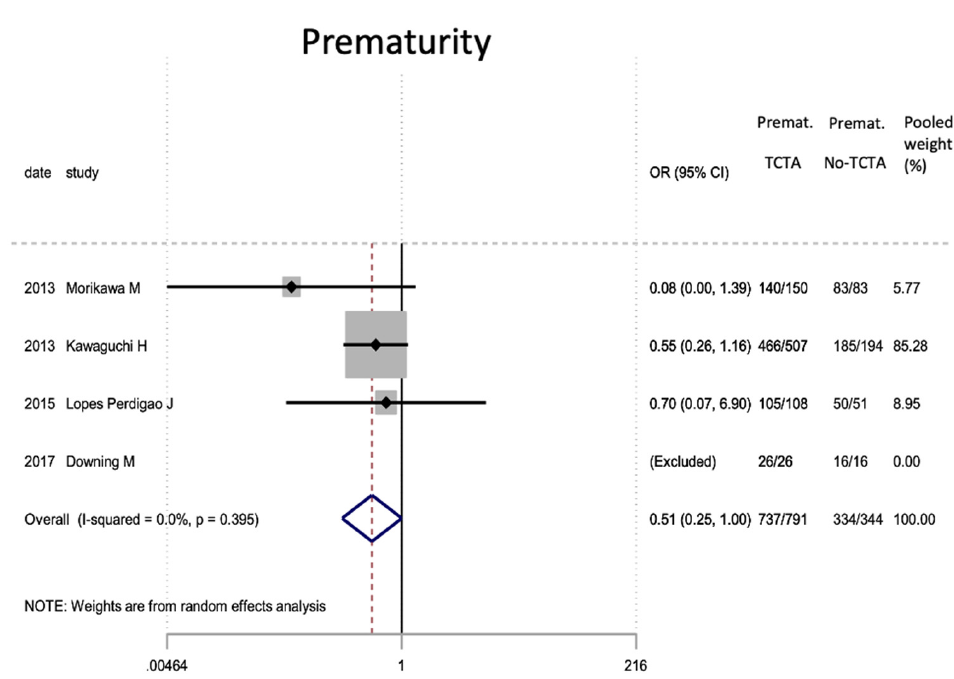
Figure 3. Results of the meta-analysis on the effect of chorionicity (TCTA vs no TCTA) on cesarean as the mode of delivery. TCTA: trichorial-triamniotic, non-TCTA: non-trichorial-triamniotic. OR = odds ratio, CI = confidence interval.